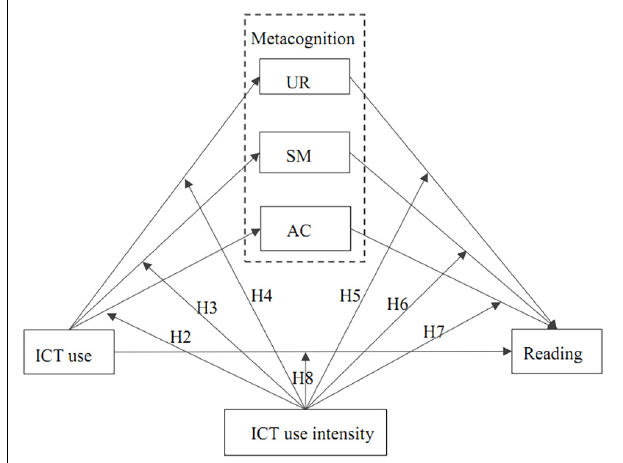
FIGURE 1 | The conceptual model of moderated mediation hypothesizes. UR, Understanding and Remembering, SM, Summarizing, AC, Assessing